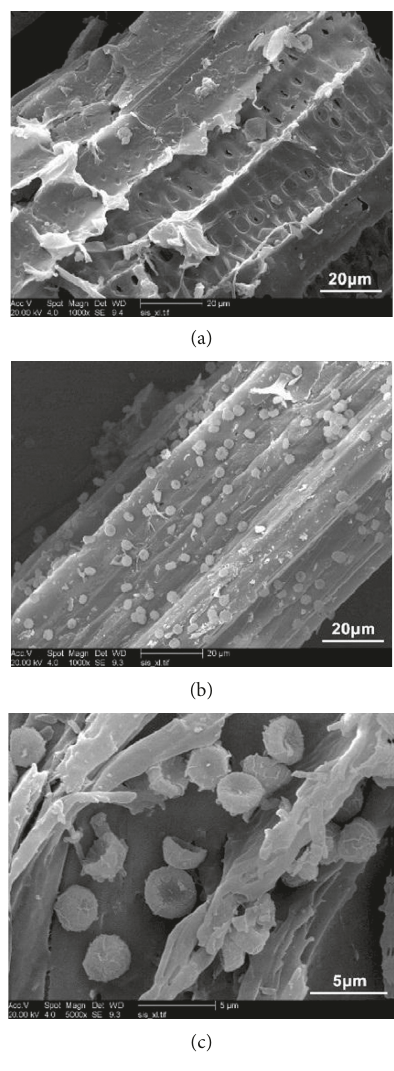
Figure 8: SEM micrographs: (a) raw corn stalk, (b) fermented corn stalk, and (c) closer inspection of Figure 7(b).